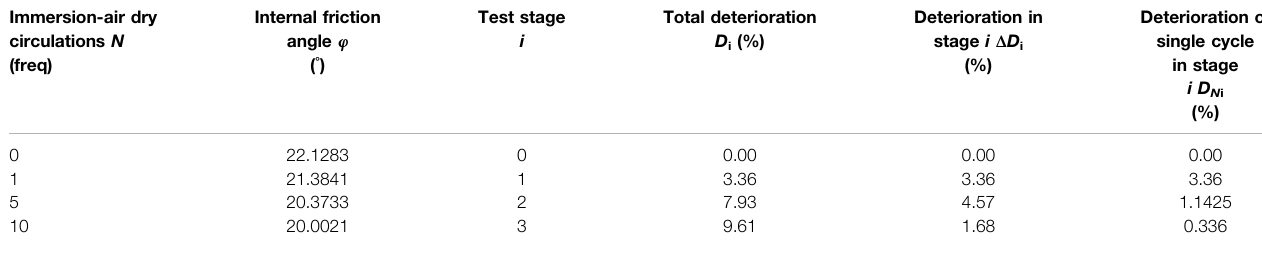
TABLE 6 | Internal friction angle deterioration analysis by immersion-air dry